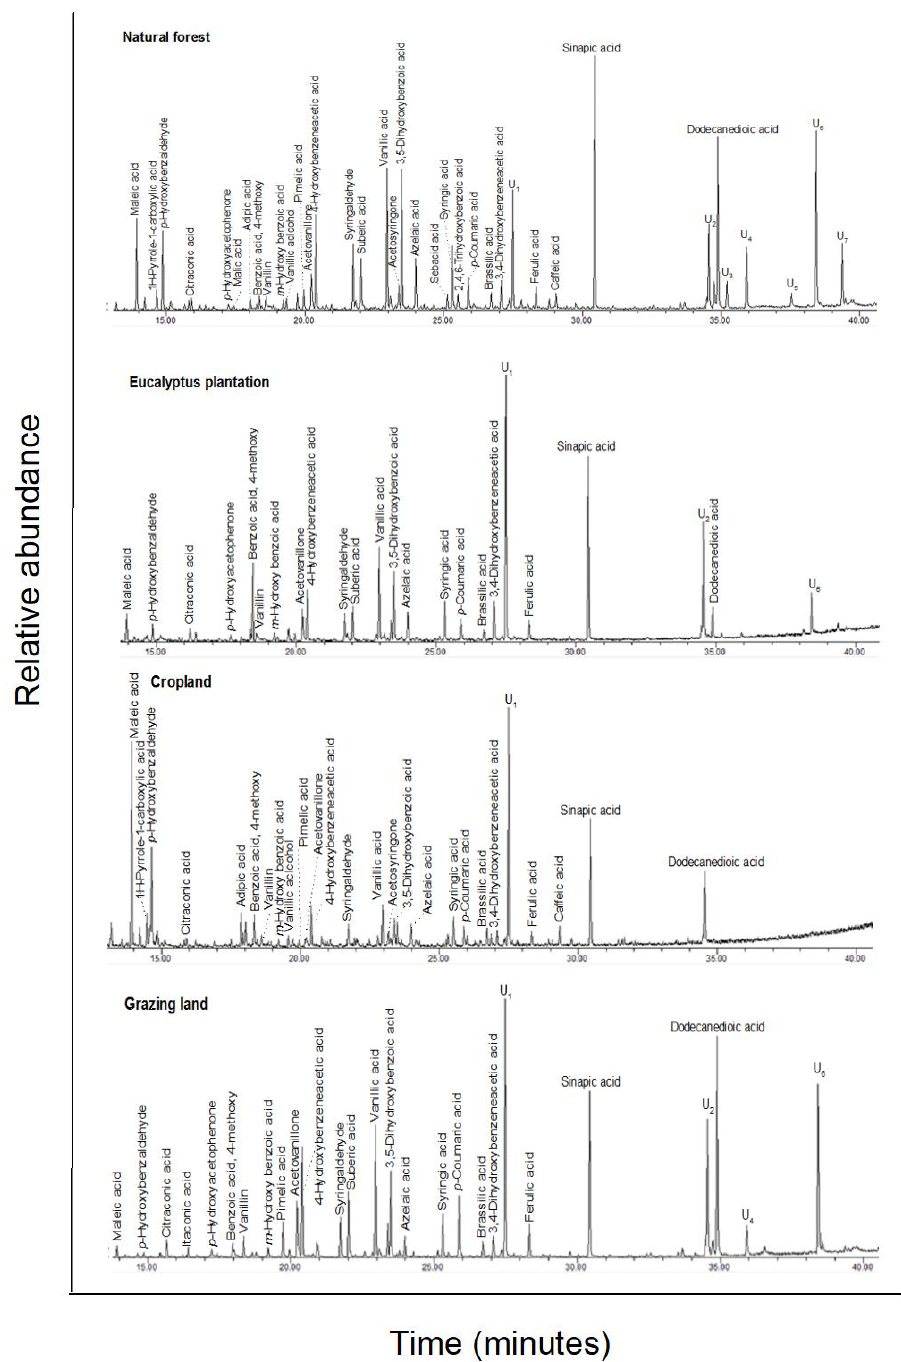
Figure A4. Total ion GC – MS chromatograms (TIC) of the silylated CuO oxidation products of four land-use systems from Gelawdios, Ethiopia. U 1 – U 7 , unidentified. Detailed description of each compound with its quantity, molecular formula, and molecular weight in Appendix Table A3.